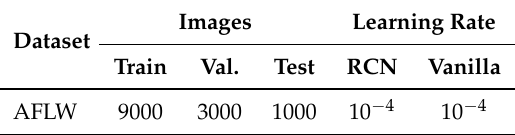
Table 2. Parameters for training AFLW